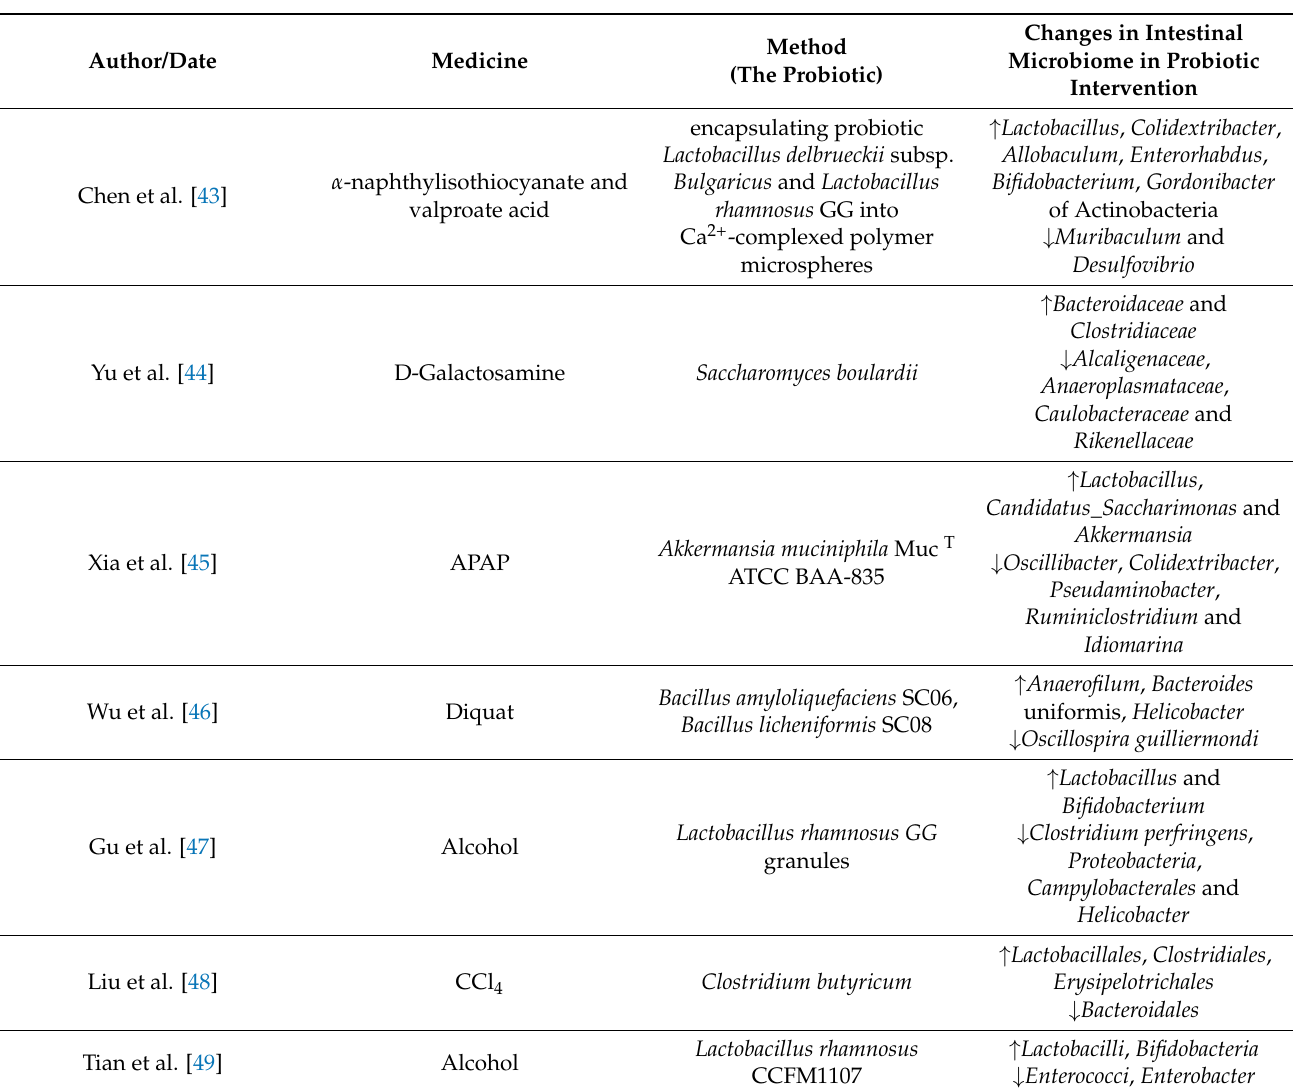
Table 2. Recent studies on gut microbiome in DILI treated with